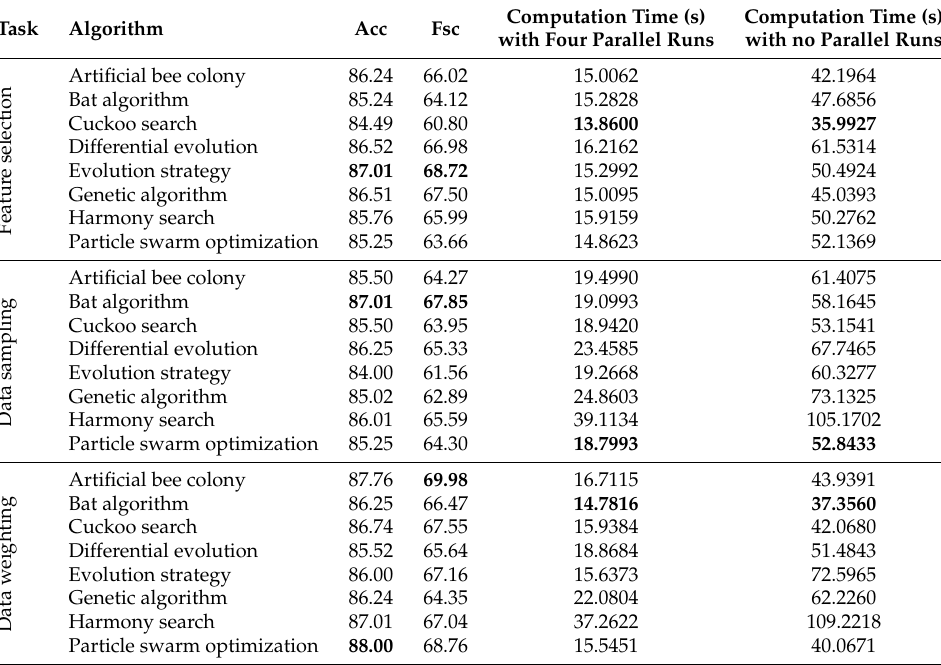
Table 4. Comparison of different nature-inspired algorithms on three data preprocessing task. Classification accuracy, F-score and computation time (in seconds) are presented. The best results are